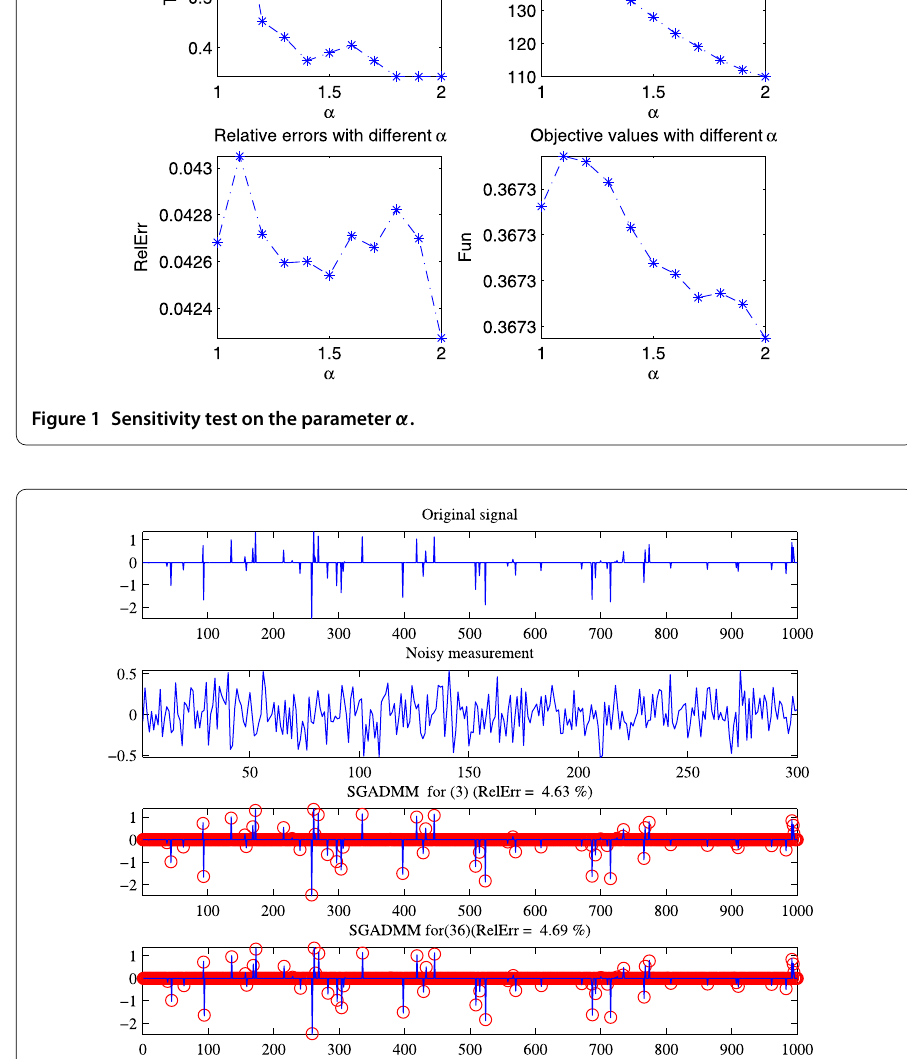
Figure 2 Numerical results of SGADMM for (3) and (35). The top: the original signal; the second: the noisy measurement; the bottom two: recovered